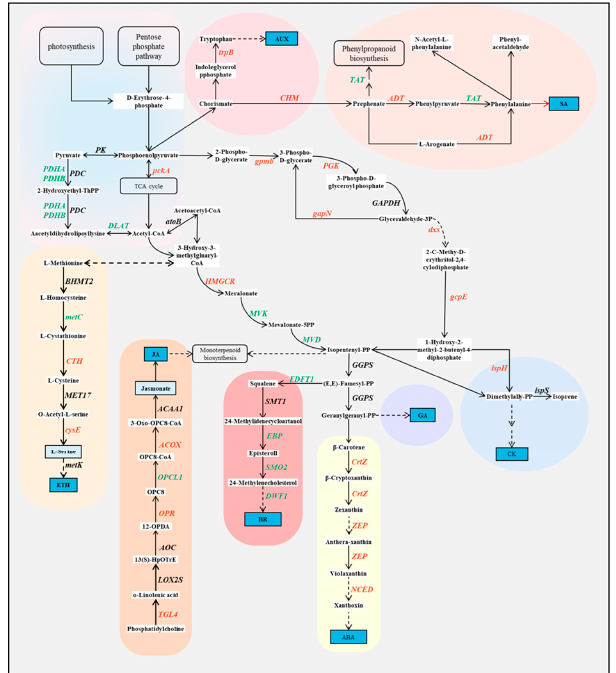
Figure 9. Overview of phytohormone biosynthetic pathway. Red represents the upregulated expres- sion of the corresponding DEGs under salt stress, green represents the downregulated expression of DEGs, and black represents the presence of both upregulated and downregulated DEGs. The corresponding expression level of each DEG is shown in Figure S1. AUX, auxin; trpB, tryptophan synthase beta chain; 4CL, 4-coumarate-CoA ligase; ACAA1, acetyl-CoA acyltransferase 1; ACOX1, acyl-CoA oxidase; ADT, arogenate/prephenate dehydratase; ADT, PDT arogenate/prephenate dehydratase; AOC, allene oxide cyclase; AOG, abscisate beta-glucosyltransferase; atoB, acetyl- CoA C-acetyltransferase; AUX, auxin; BHMT2, homocysteine S -methyltransferase; CDK2, cyclin- dependent kinase 2; CHI, chalcone isomerase; CHM, chorismate mutase; CHS, chalcone synthase; CKS1, cyclin-dependent kinase regulatory subunit CKS1; crtZ, beta-carotene 3-hydroxylase; CTH, cystathionine gamma-lyase; CYP73A, trans-cinnamate 4-monooxygenase; CYP85A1, brassinosteroid- 6-oxidase 1; CYP90B1, steroid 22-alpha-hydroxylase; CYP93C, 2-hydroxyisoflavanone synthase; cysE, serine O -acetyltransferase; cysK, cysteine synthase A; DLAT, pyruvate dehydrogenase E2 component (dihydrolipoamide acetyltransferase); DLD, dihydrolipoamide dehydrogenase; DMAPP, dimethylally-PP; DWF1, delta24-sterol reductase; dxs, 1-deoxy-d-xylulose-5-phosphate synthase; EBP, cholestenol delta-isomerase; ECDS, ent-copalyl diphosphate synthase; FDFT1, farnesyl-diphosphate farnesyltransferase; GAPDH, glyceraldehyde 3-phosphate dehydrogenase; gapN, glyceraldehyde-3- phosphate dehydrogenase (NADP+); gcpE, (E)-4-hydroxy-3-methylbut-2-enyl-diphosphate synthase; GGPS, geranylgeranyl diphosphate synthase, type II; gpmB, probable phosphoglycerate mutase; HMGCR, hydroxymethylglutaryl-CoA reductase (NADPH); ispH, 4-hydroxy-3-methylbut-2-en-1-yl diphosphate reductase; ispS, isoprene synthase; LED, leucoanthocyanidin dioxygenase; LOX2S, lipoxygenase; metK, S-adenosylmethionine synthetase; MPK6, mitogen-activated protein kinase 6; MVD, diphosphomevalonate decarboxylase; MVK, mevalonate kinase; NCED, 9-cis-epoxycarotenoid dioxygenase; OPCL1, OPC-8:0 CoA ligase 1; OPR, 12-oxophytodienoic acid reductase; pckA, phos- phoenolpyruvate carboxykinase (ATP); PDC, pyruvate decarboxylase; PDHA, pyruvate dehydro- genase E1 component alpha subunit; PDHB, pyruvate dehydrogenase E1 component beta subunit; PGK, phosphoglycerate kinase; PK, pyruvate kinase; SMO2, 4-alpha-methyl-delta7-sterol-4alpha- methyl oxidase; SMT1, sterol 24-C-methyltransferase; TAA1, l-tryptophan-pyruvate aminotrans- ferase; TAT, tyrosine aminotransferase; TGL4, TAG lipase/steryl ester hydrolase/phospholipase A2/LPA acyltransferase; trpB, tryptophan synthase beta chain; UGT74B1, N -hydroxythioamide S -beta-glucosyltransferase; ZEP, zeaxanthin